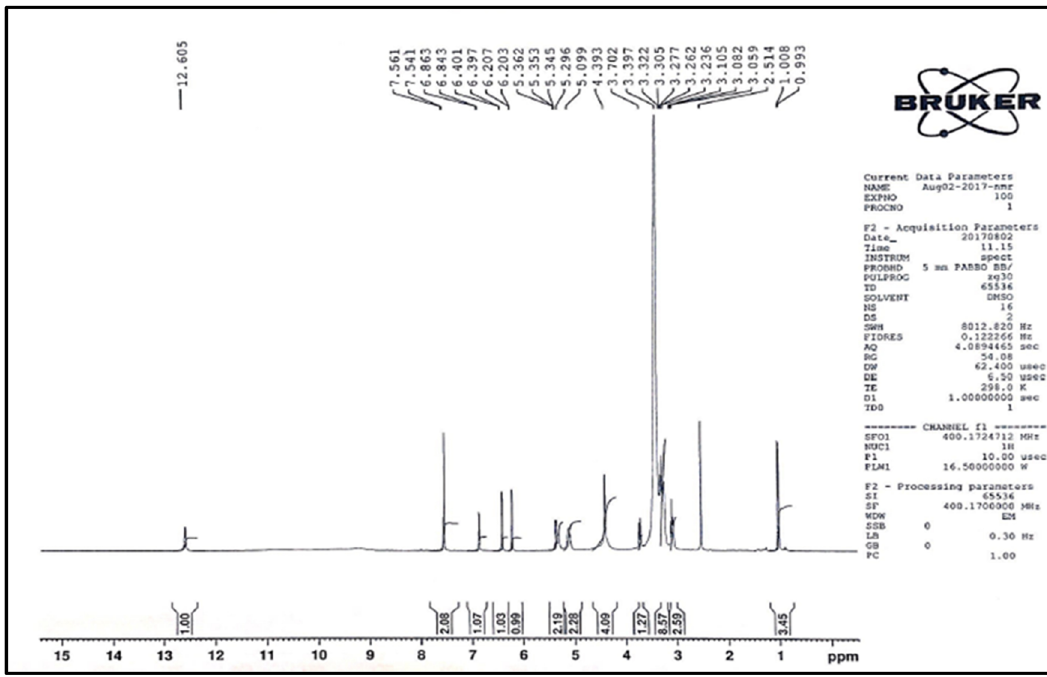
Figure A1: 1 H NMR spectrum of Rut ( DMSO - d 6 , 400 MHz ) .